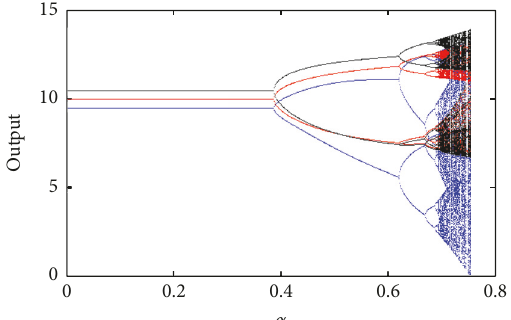
Figure 20: Bifurcation diagram with 𝛼 , 𝑘 = 0.5 .